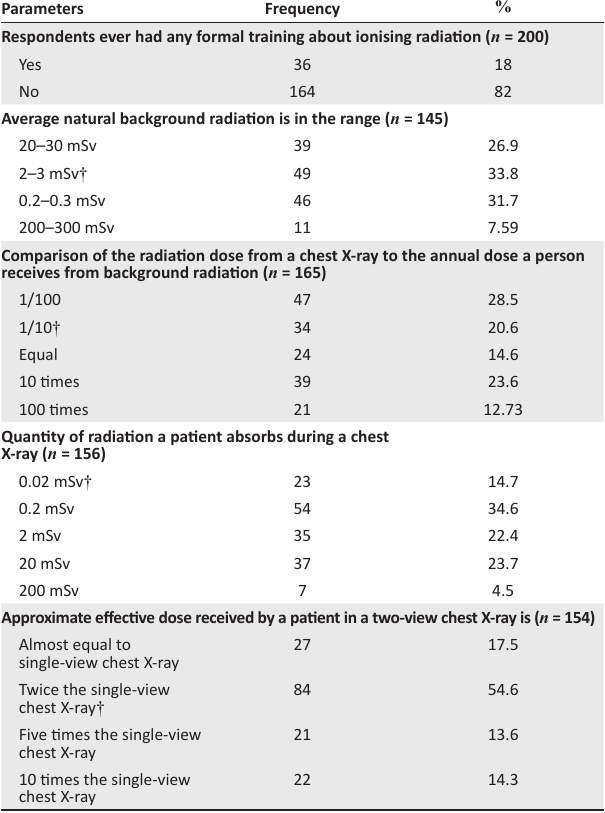
TABLE 1: Doctors’ awareness of exposure to diagnostic radiation. Parameters